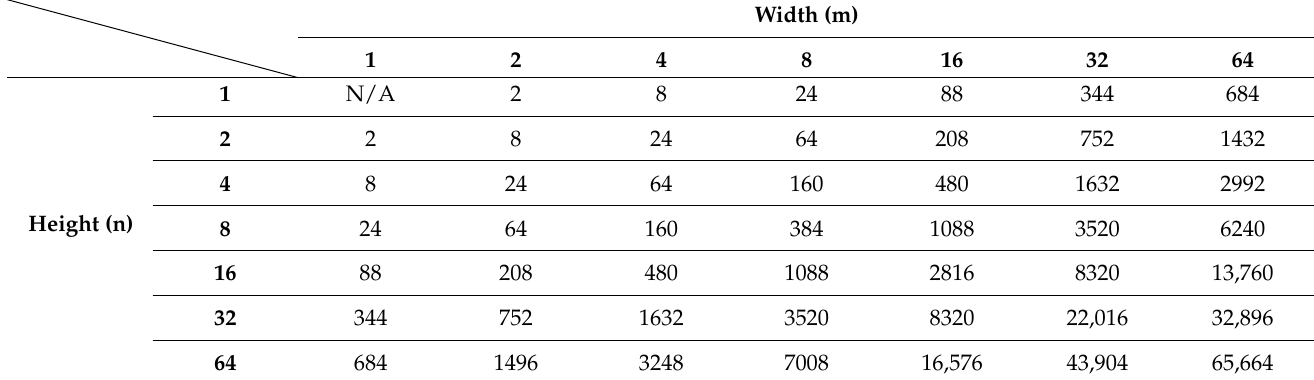
Table 1. Number of multiplications when the horizontal and vertical transforms are both DCT-II in the VTM-8.2.